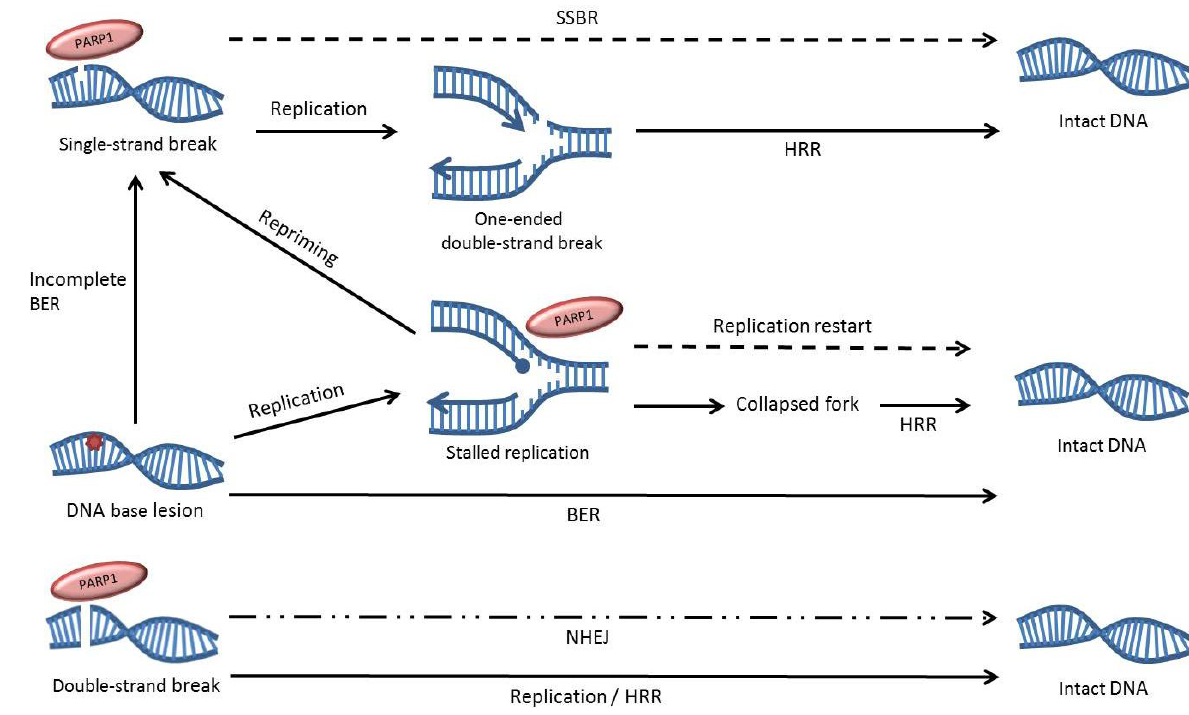
Figure 2. Overview of the role of PARP1 in DNA repair. PARP1 can bind to DNA single- strand breaks, double-strand breaks and replication fork structures and influences the repair of these lesions. Dotted lines indicate pathways that are impaired by PARP inhibition. The dotted and dashed line represents the partial contribution of PARP1 to non-homologous end joining (NHEJ), as it only appears to be involved in a backup form of the repair